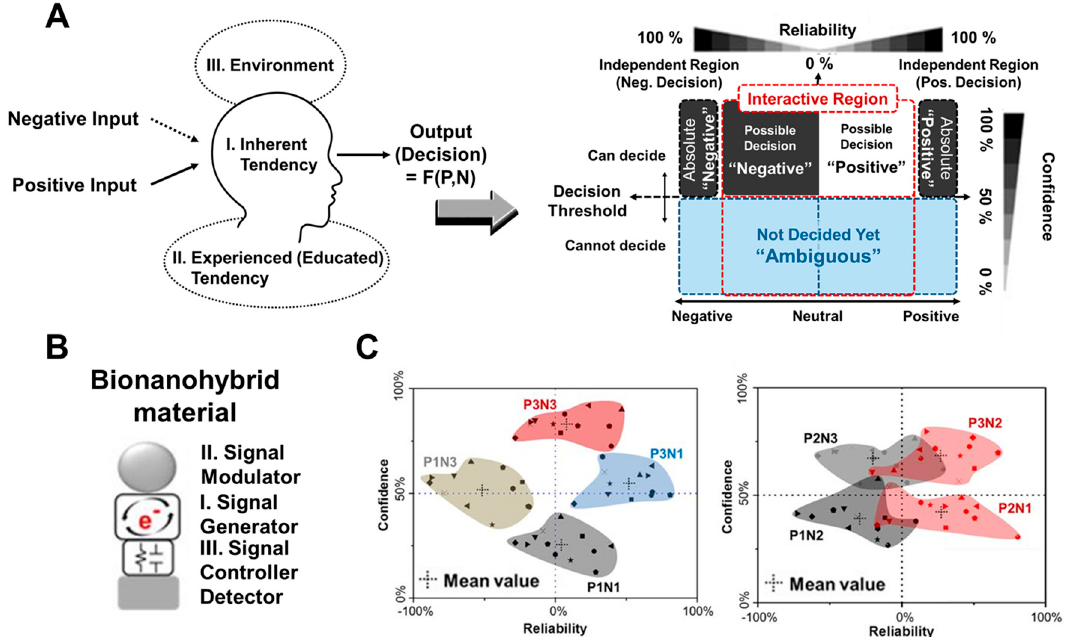
Figure 6. Analog decision mimicking bioelectronic device. ( A ) Schematic image and theory of this bioelectronic device through the analogously processed output signals by two different external factors inputted (negative input and positive input) by electrochemical investigation. ( B ) Bionanohybrid material used for this device composed of metalloprotein used as signal generator, organic chemical linkers as signal controller, and inorganic materials used for signal modulation. ( C ) The plotted results of analog decision-making based on the analysis of electrochemical signal by defined external factors showed the decision variation of 12 persons based on the defined threshold values. (Reproduced with permission from [59], the figures follow the terms of use under a Creative Commons Attribution 4.0 International License.).